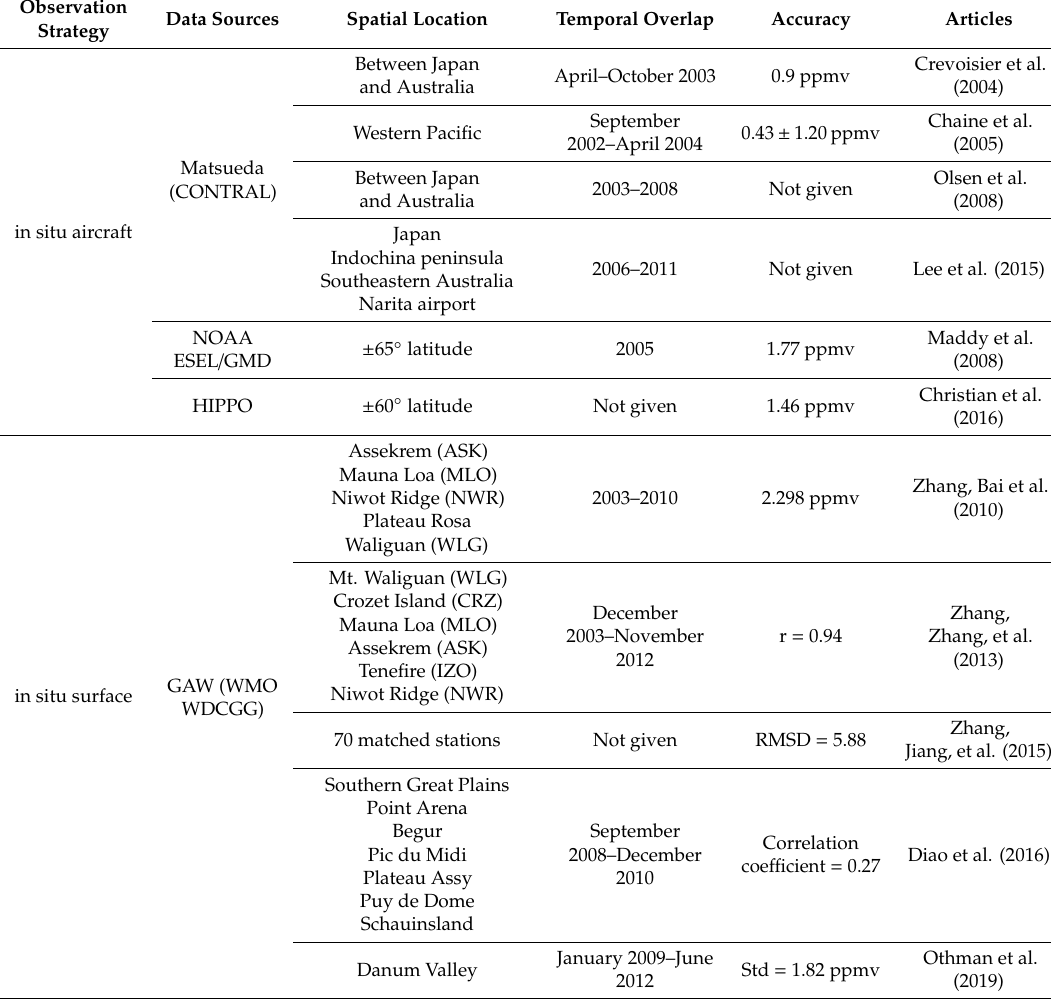
Table 2. Summary of the studies using di ff erent in situ measurements to compare and validate Atmospheric Infrared Sounder (AIRS) CO 2